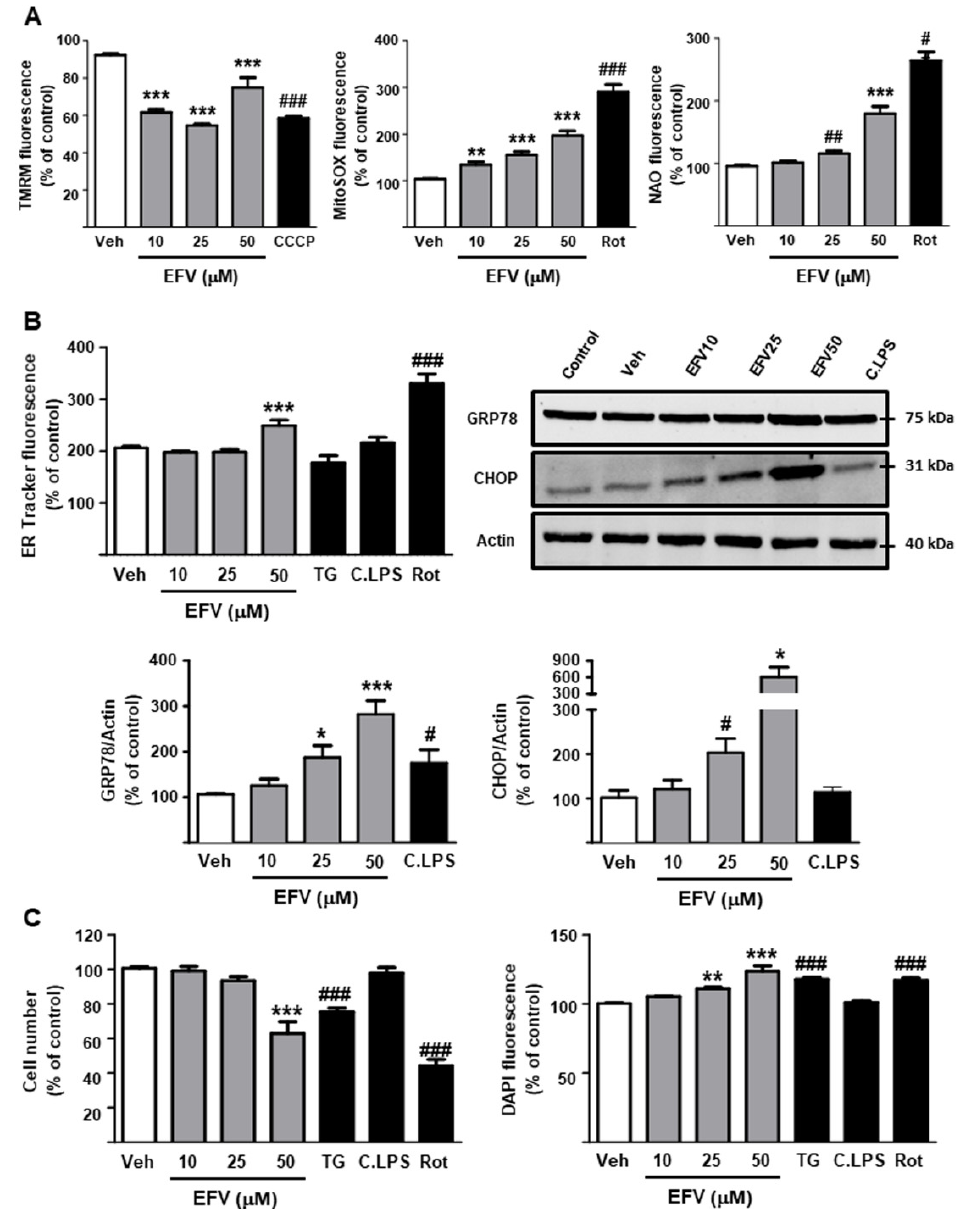
Figure 3. Efavirenz treatment alters cellular function in LX2 cells, thus promoting their activation. ( A ) Quantitative analysis of mitochondrial function by fluorescence microscopy: mitochondrial membrane potential (TMRM fluorescence), mitochondrial superoxide production (MitoSOX fluorescence), mitochondrial morphology and mass (NAO fluorescence) (n = 5). ( B ) Assessment of unfolded protein response and endoplasmic reticulum stress: quantitative analysis of the endoplasmic reticulum signal (ER-Tracker Red fluorescence) and protein expression of the classic markers of these processes, GRP78 and CHOP. Representative Western Blot image of these proteins and summary of densitometry data after 24 h treatment (n = 5–6). ( C ) Assessment of cellular proliferation/viability: quantitative analysis of cell number (Hoechst 33342-nuclei) and nuclear fluorescence intensity (n = 6). Data were represented as mean ± SEM, calculated as percentage of control (untreated cells) and analyzed by one-way ANOVA multiple comparison test followed by a Newman–Keuls test (* p < 0.05, ** p < 0.01, *** p < 0.001 versus the respective vehicle). Thapsigargin (TG), rotenone (Rot) and cocktail of LPS (C.LPS) were independently analyzed by a Student’s t -test ( # p < 0.05, ## p < 0.01, ### p < 0.001).